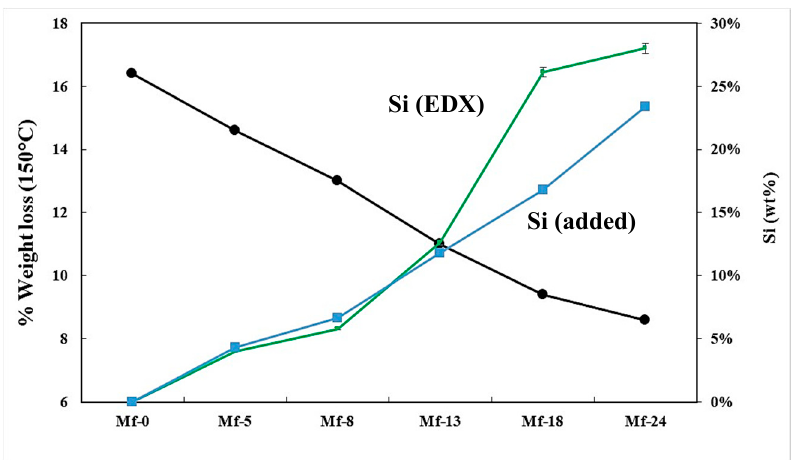
Figure 7. Correlation between weigh loss ( T = 150 ◦ C) and Si concentrations for the electrospun microfibres. Error bars of Si (EDX) measures are obtained from data in Table 2.